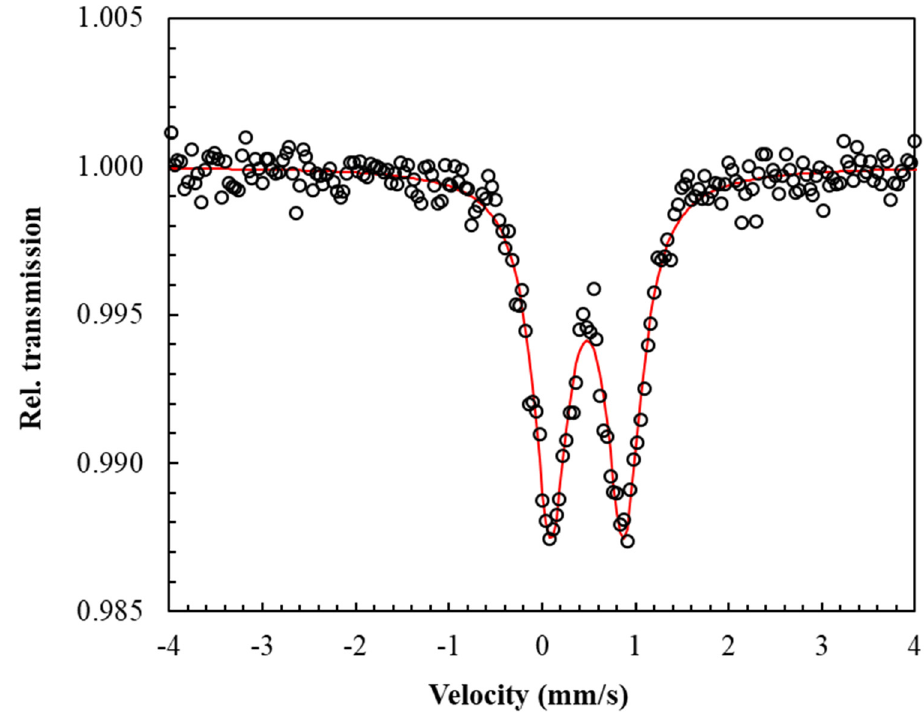
Figure 3. Typical zero-field 57 Fe Mössbauer spectrum of Fe III -CS-GLA recorded at 80 K (the iron concentration during preparation was 7.5 mM). The solid line represents the best fit with parameters δ = 0.48 mm/s, Δ E Q = 0.79 mm/s and line width Γ = 0.46 mm/s.